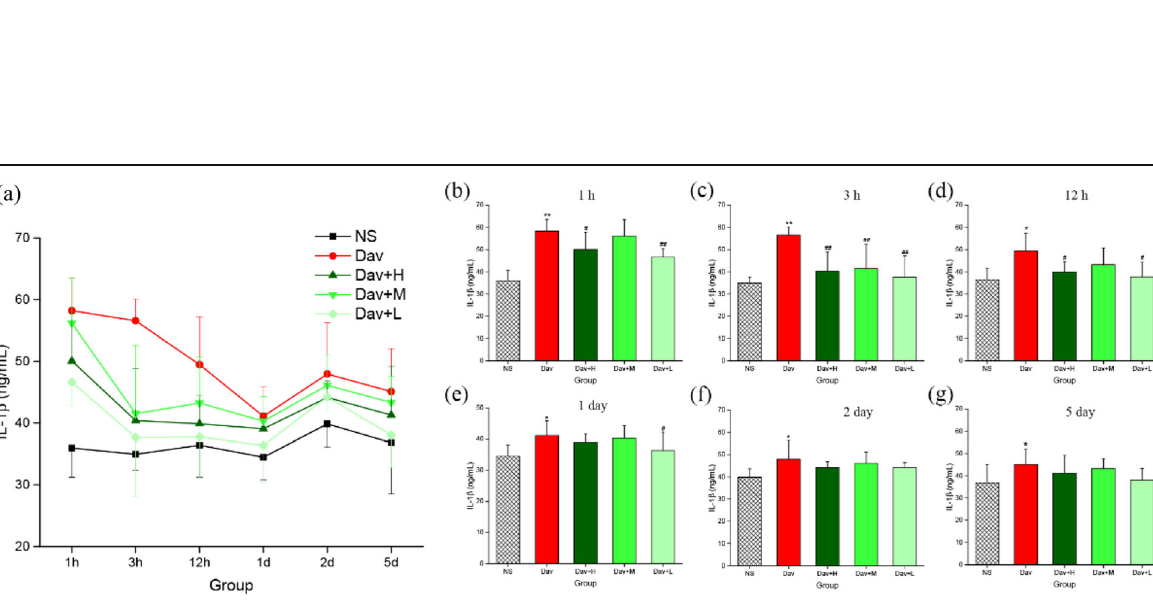
Fig. 8 Effects of Phellodendri Chinensis Cortex Carbonisata-carbon dots (PCCC-CDs) on IL-1 β level in the kidney tissue. a IL-1 β level changes in 1 h, 3 h, 12 h, 1 day, 2 days, and 5 days. IL-1 β levels in ( b ) 1 h, ( c ) 3 h, ( d ) 12 h, ( e ) 1 day, ( f ) 2 days, and ( g ) 5 days. Mice were treated with normal saline (NS), D.acutus venom (Dav, 1 mg/kg) and high (H), medium (M), and low (L) doses of PCCC-CDs + Dav (1 mg/kg). Data are represented as mean ± SD of six animals of each group. * p < 0.05 and ** p < 0.01 compared with control group treated with normal saline (NS). # p < 0.05 compared with Dav